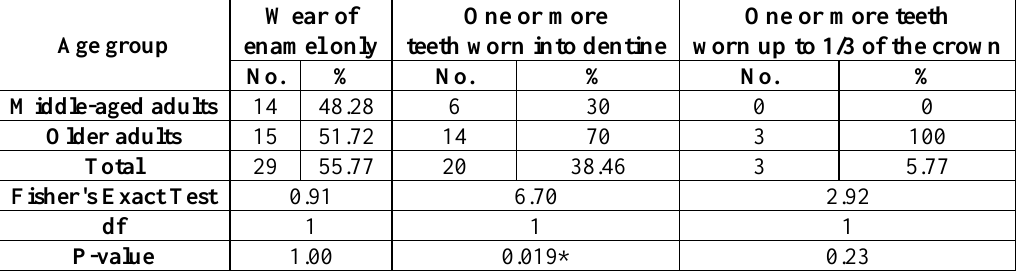
Table 2: Frequency distribution of tooth wear scores according to severity of tooth wear by age